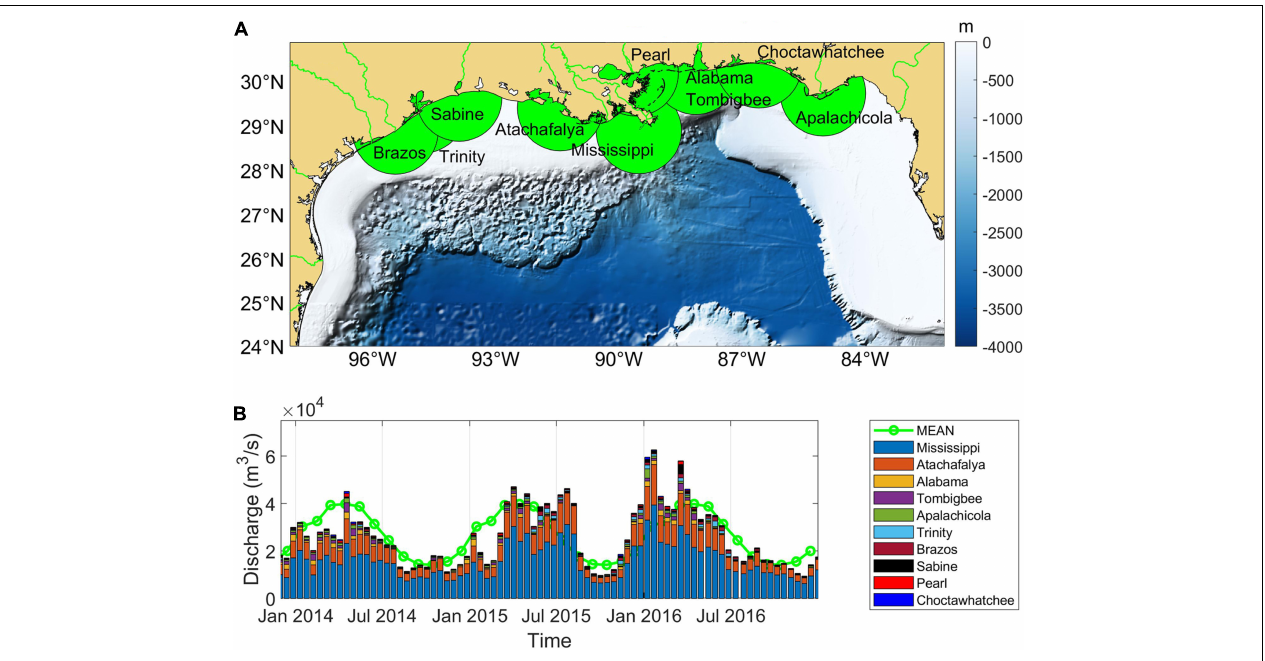
FIGURE 1 | (A) Bathymetry of the Gulf of Mexico with indicated the river mouth of the rivers considered in the simulations (green dots) and major shelves. Rivers Alabama and Tombigbee share the same river mouth in our model setup. The dots cover the region where the bogus freshwater fluxes are applied in the passive configuration. (B) Freshwater discharge rate of each river from December 2013 to August 2016. Vertical dash lines show the 1st day of January and July during this period. Green dotted line indicates the mean discharge rate, calculated as monthly means over the 11-year period Jan 2010 – Nov